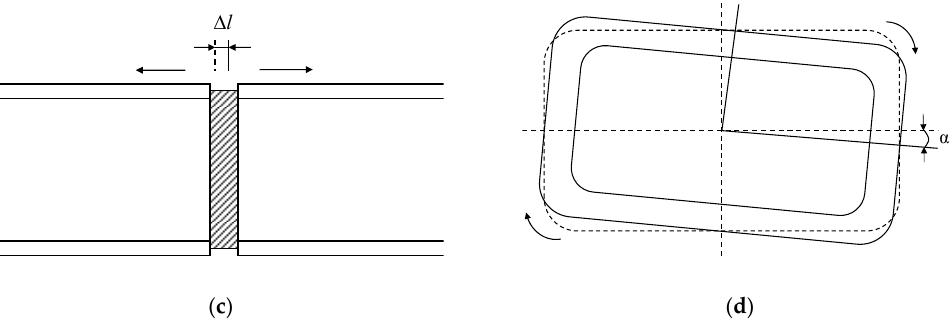
Figure 8. The four deformation modes of immersed tunnel joint (redrawn according to Xie et al. [26]): ( a ) bending; ( b ) shear; ( c ) expansion; ( d ) torsion.